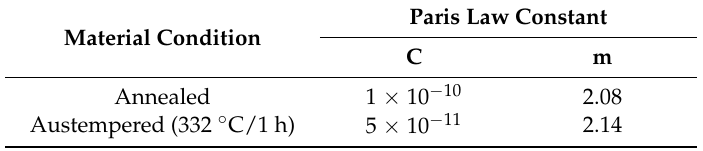
Table 6. Comparison of Paris Constants for the Uncharged 4140 Steel Alloy.